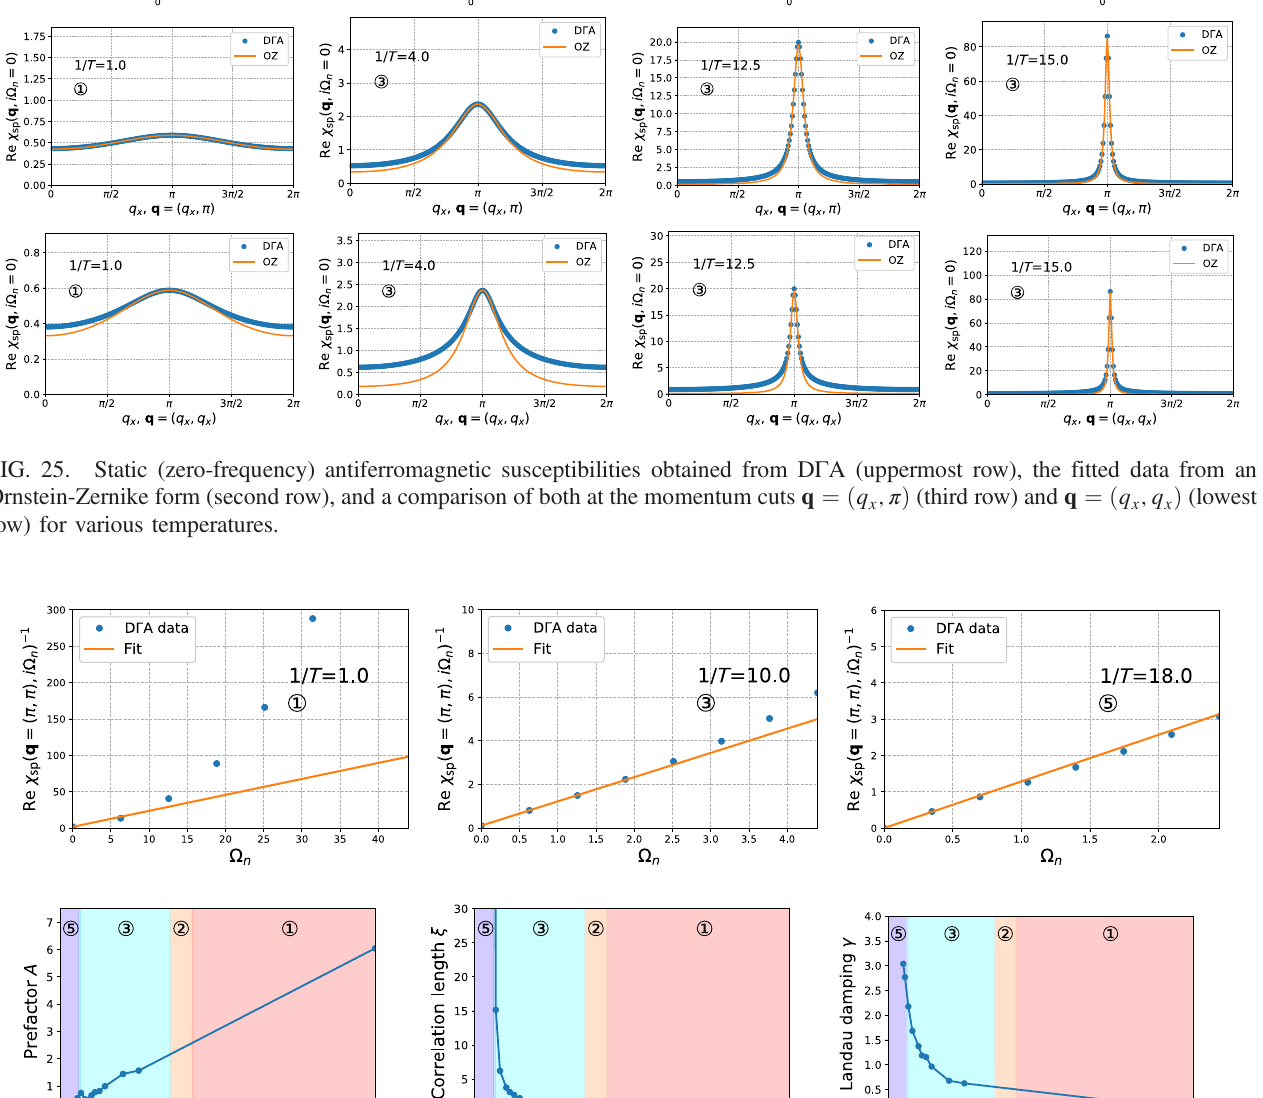
FIG. 26. Upper row: Fits of the frequency-dependent part of the (inverse) antiferromagnetic susceptibility from D Γ A by an Ornstein- Zernike form at three dierent temperatures. Lower row: The prefactor A and the magnetic correlation length ξ have been fixed to the ones of the static propagator and their temperature dependencies together with the one of the Landau damping γ are